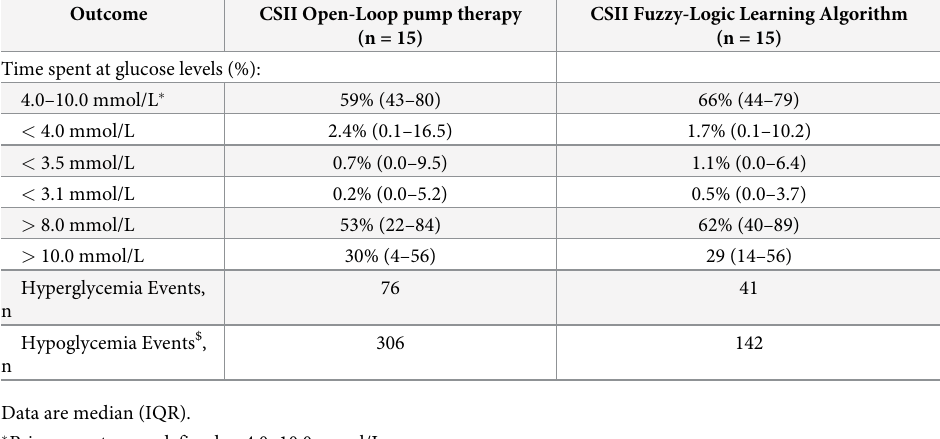
Table 1. CSII Open-Loop vs CSII Fuzzy-Logic Learning Algorithms comparison for the overall simulation study period of 31 days across the 15